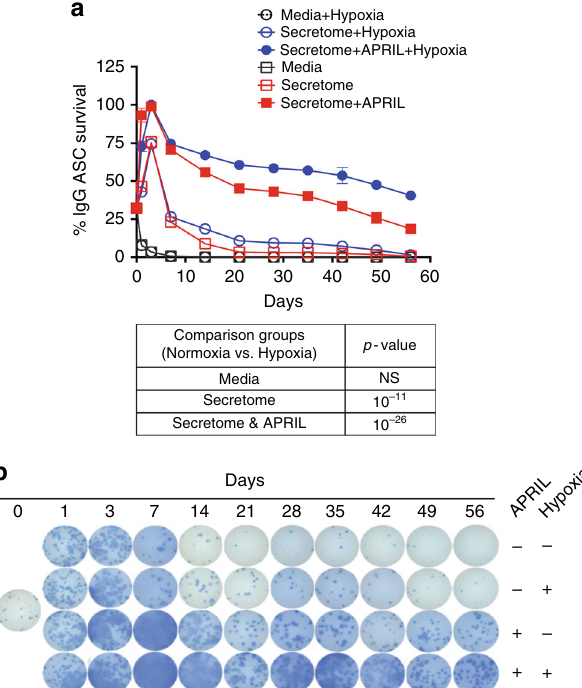
Fig. 6 Survival of blood ASC is enhanced under hypoxic conditions with the MSC secretome and APRIL. a Circulating ASC post-tetanus vaccination from one healthy adult were cultured under the following conditions in normoxia: media alone (black open squares), secretome alone (open red squares), or secretome + APRIL (red closed squares) and under hypoxia conditions: media alone (black open circles), secretome alone (blue circles), or secretome + APRIL (blue closed circles). Percentage of IgG Elispots were normalized to the maximal frequency on day 3. Data are representative of four different blood ASC from four adults after vaccination ( p -values shown in the table below). b Representative images of Elispot wells from the experiments in a are shown. Number of ASC per well: 1333 except on wells from days 21 – 56 for MSC secretome + APRIL in normoxia or hypoxia (800) to show images in a countable